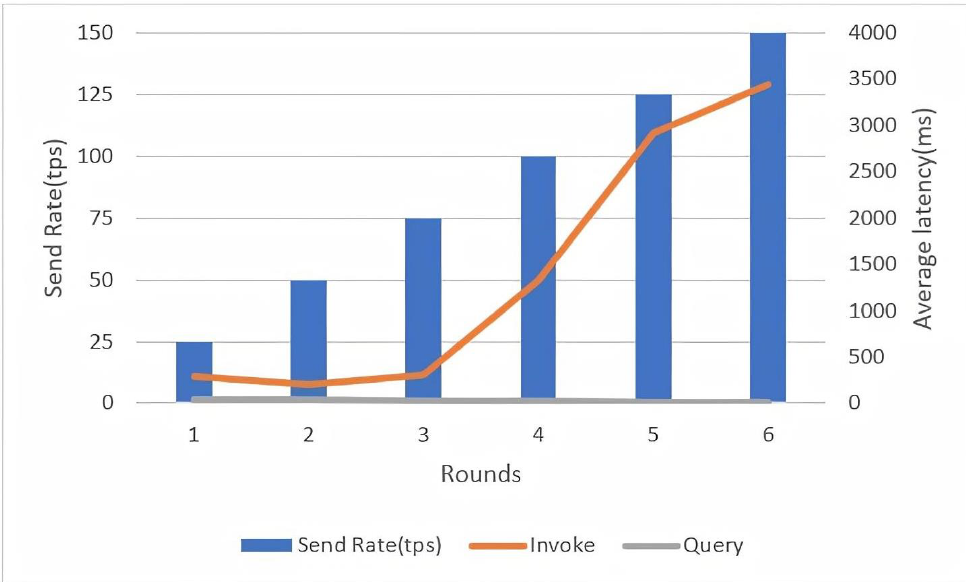
Figure 6. Impact of send rate on network average latency.